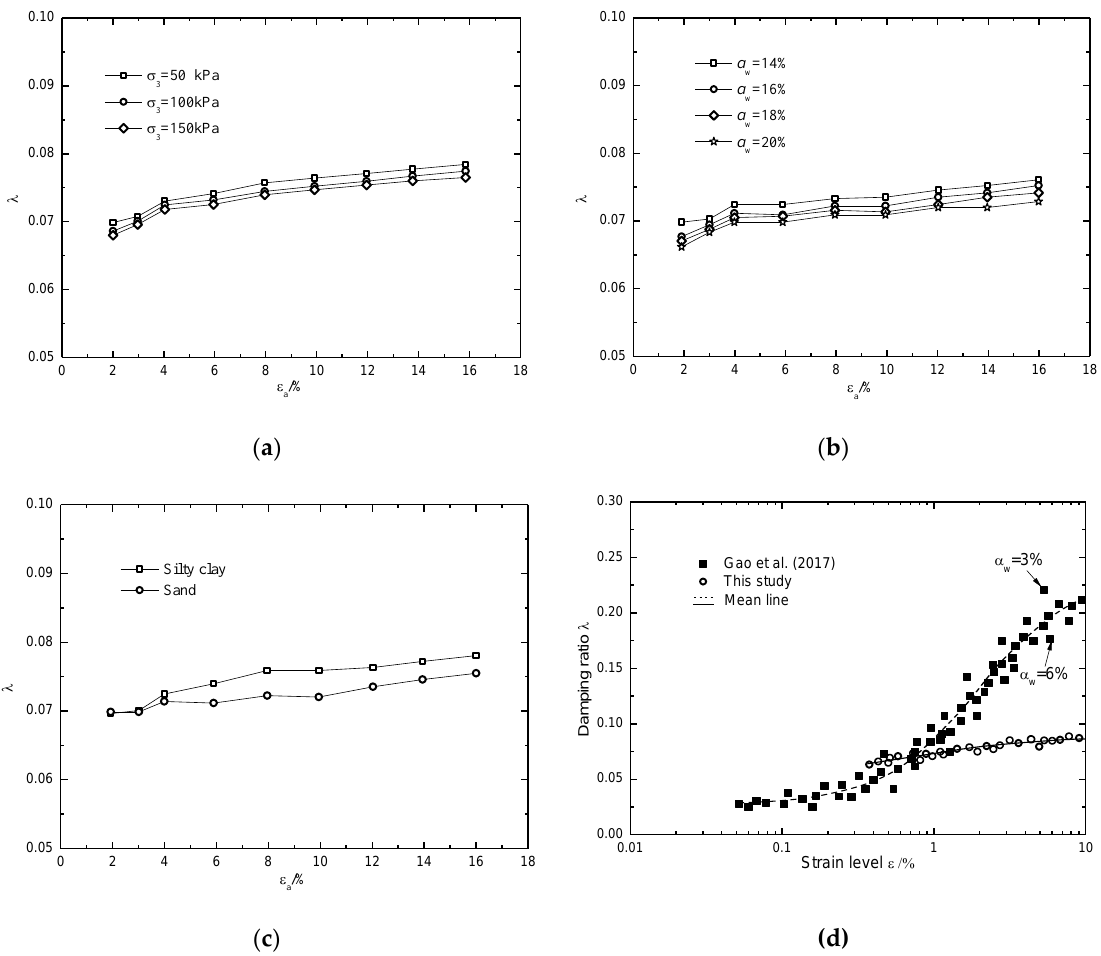
Figure 11. The damping ratio versus axial total strain under different condition: ( a ) Silty lightweight soil with a w = 14%; ( b ) Sandy lightweight soil with σ 3 = 100 kPa; ( c ) Under a w = 14% and σ 3 = 50 kPa; and, ( d ) Comparison with Gao et al.’s results.